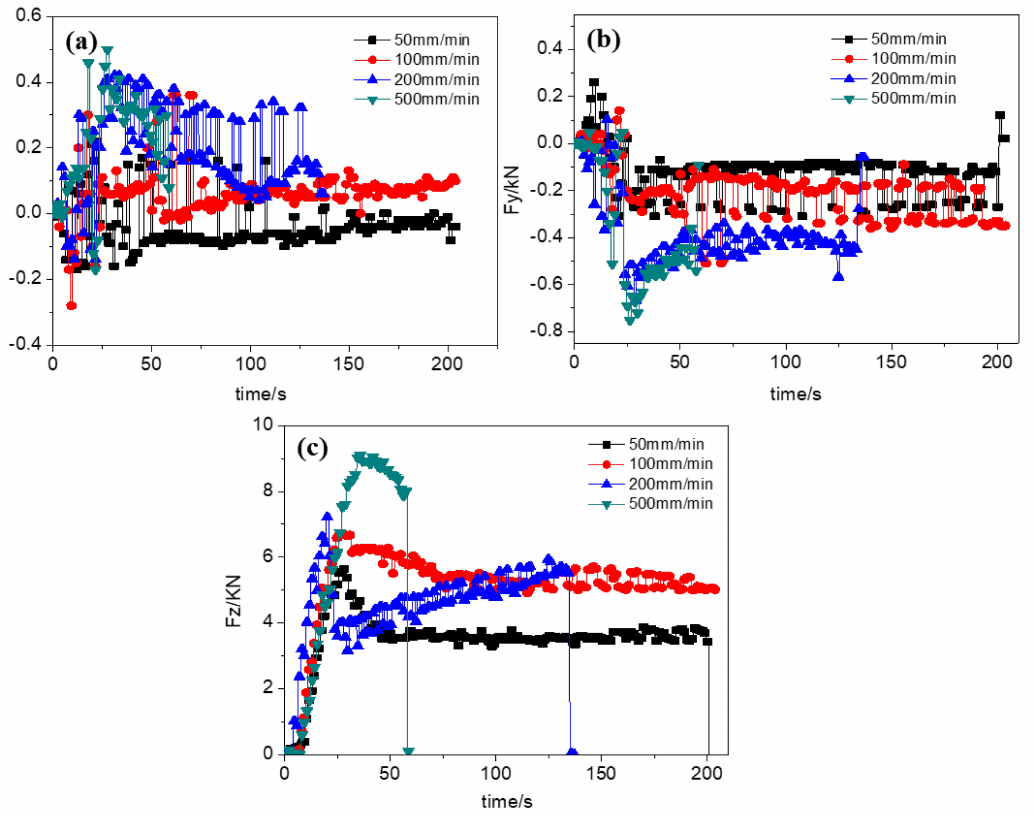
Figure 3. Fx, Fy, and Fz forces during robotic FSW of 2198 − T8 Al − Li alloy. ( a ) Fx force; ( b ) Fy force; ( c ) Fz